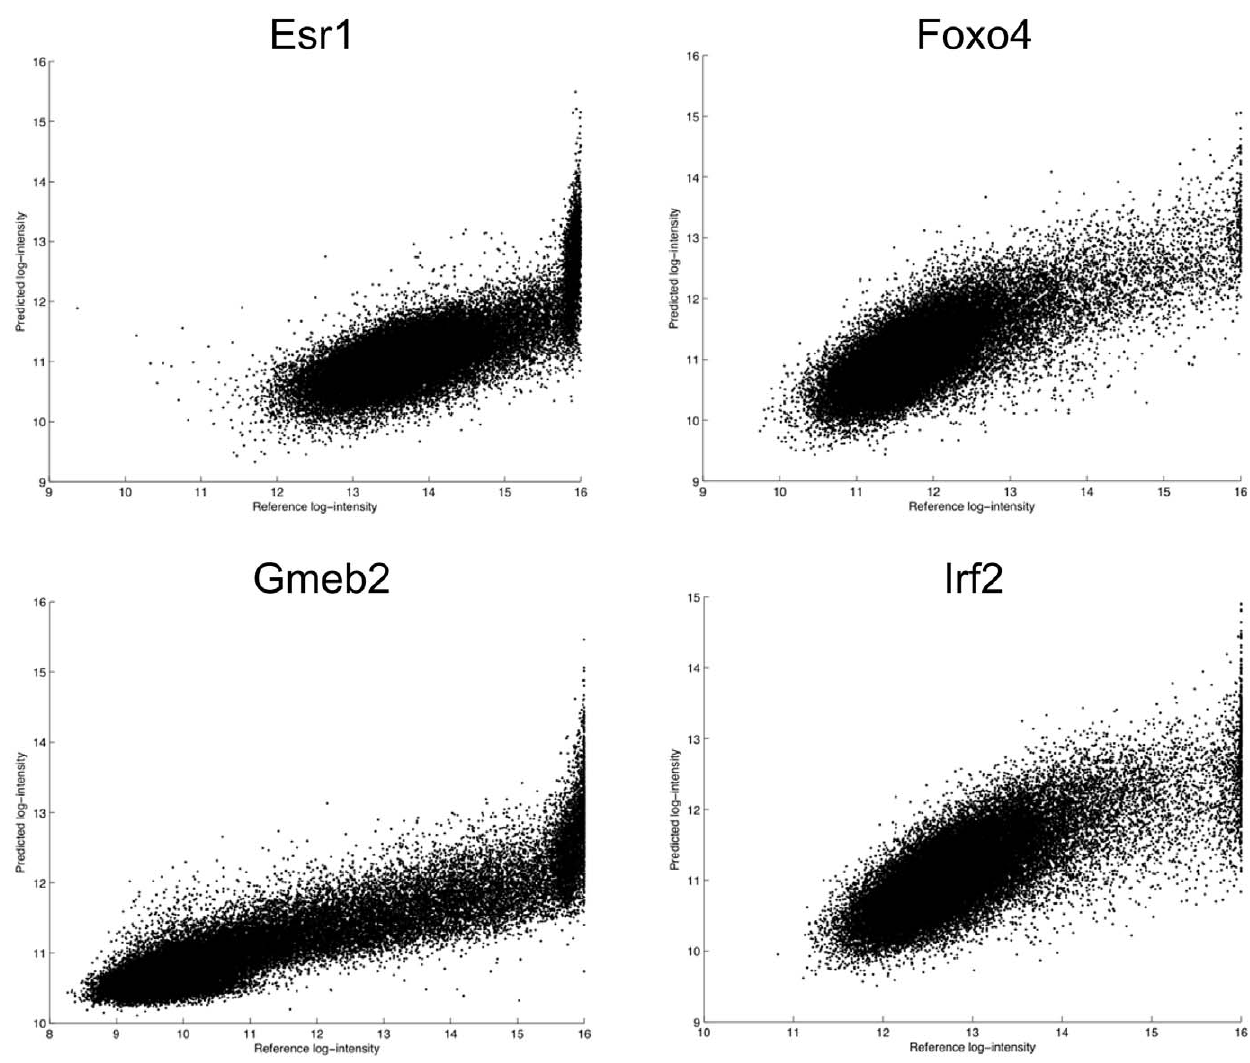
Figure 8. Scatter plots of predicted intensities and saturated reference samples. The y-axis represents predicted probe intensities, while the x-axis represents true probe intensities on the reference array. The scatter plots clearly indicate the negative effect that reference sample saturation has on assessing the accuracy of model predictions.